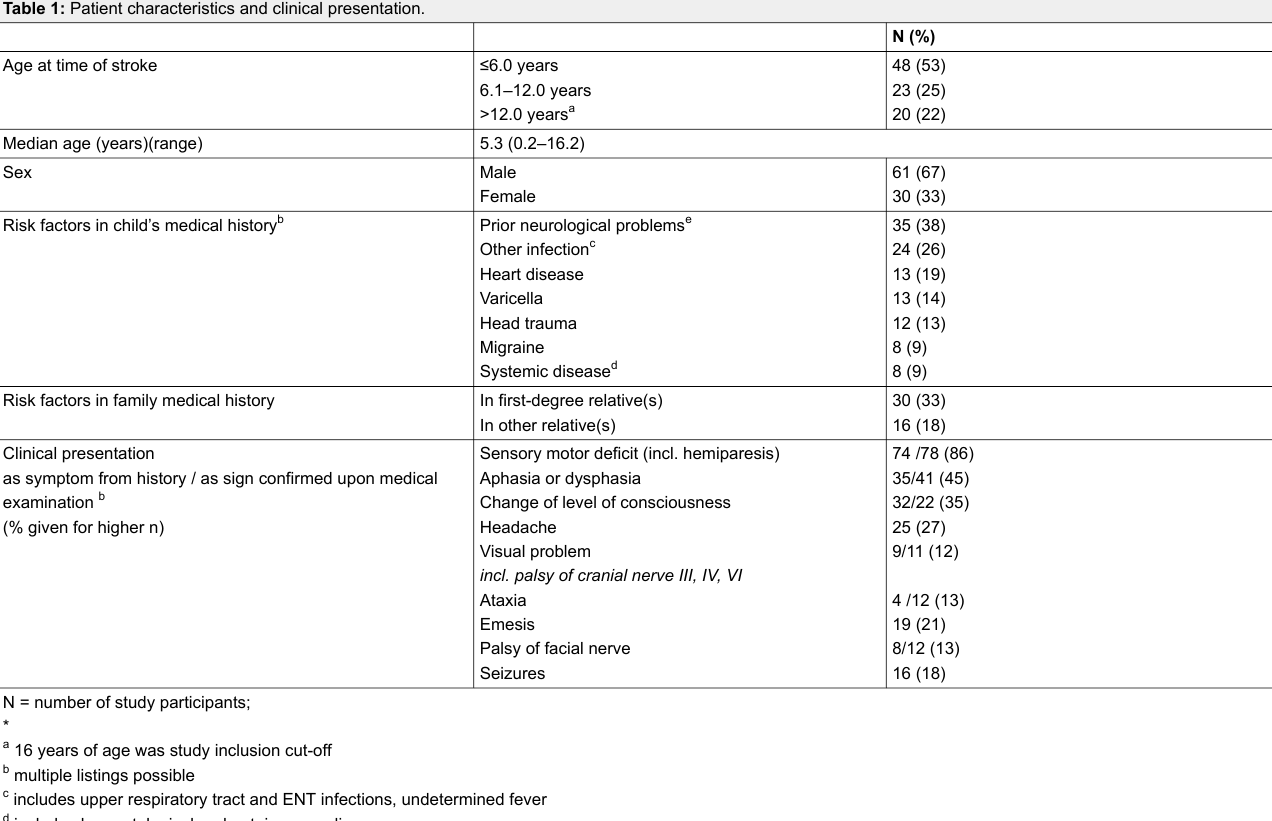
Table 1: Patient characteristics and clinical